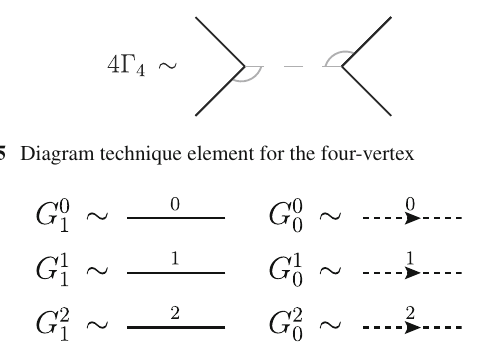
Fig. 6 Diagram technique elements for the new auxiliary functions, see formulae